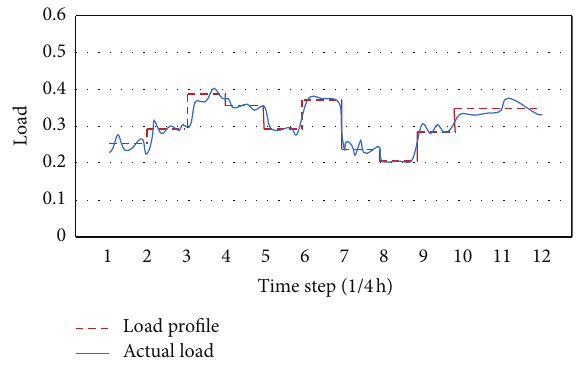
Figure 6: Load profile versus actual